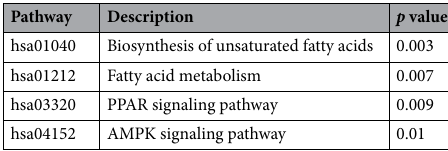
Table 2. KEGG pathway of SCD5.